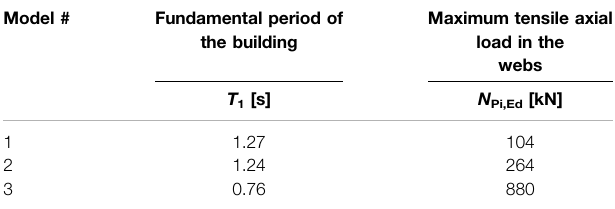
TABLE 3 | Effect of the roof element-to-main beam connections on fundamental period of the building and design tensile load acting on the